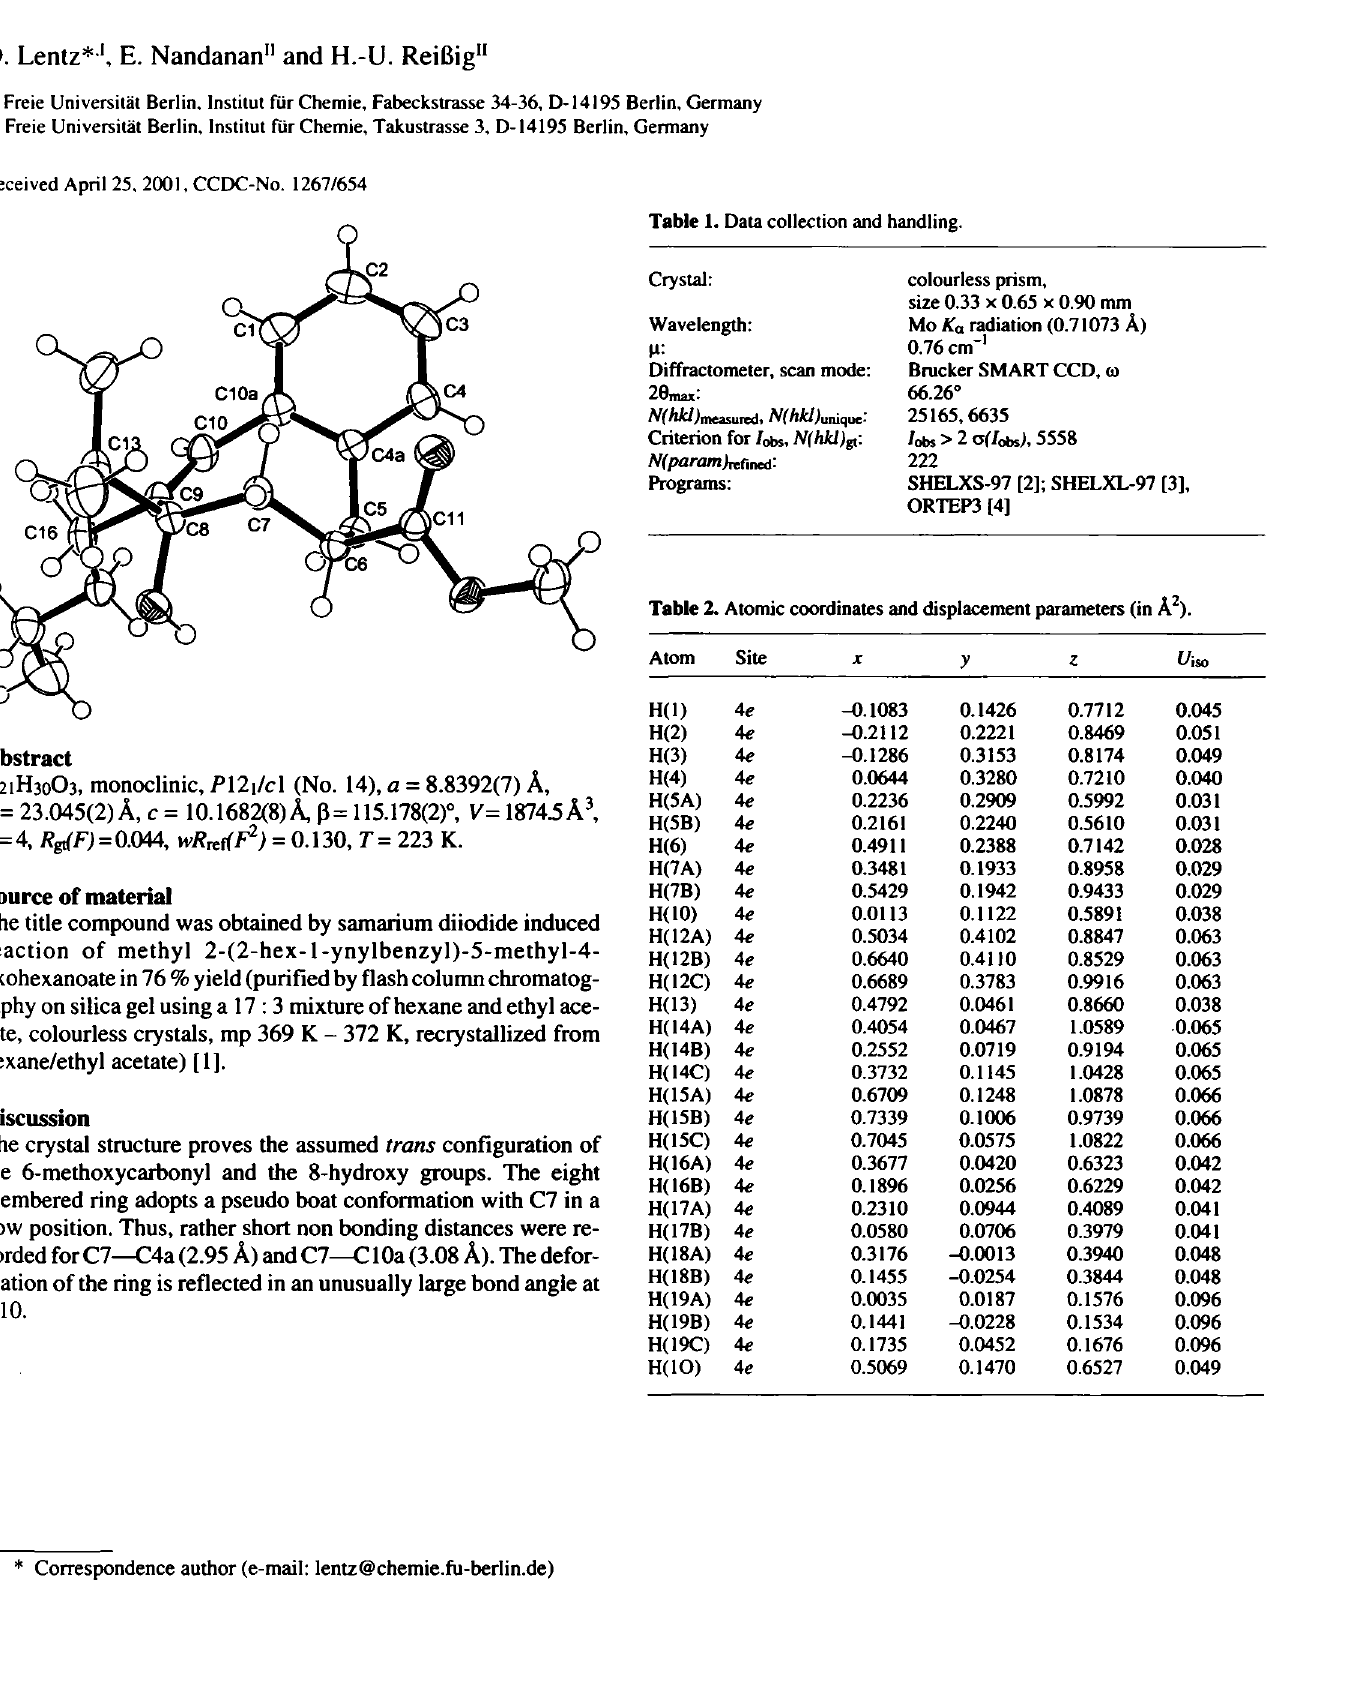
Table 1. Data collection and handling.